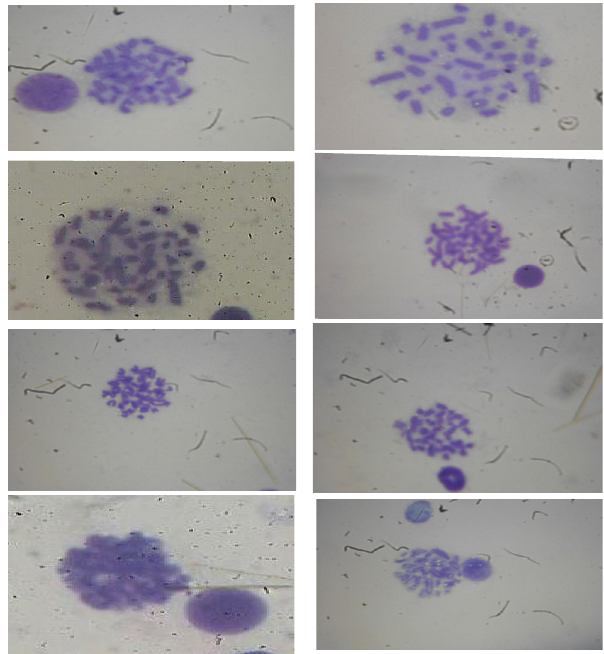
Fig. 3. Types of chromosomal aberrations in rat bone marrow cells treared with acetate lead.a: control; b: centromeric attenua- tion (Cat) and fusion (Fu); c: Fusion (Fu); d: chromasomal ring (R); e: centromeric attenuation (Cat); f: chromasomal ring (R) and fusion (F); g: deletion (D), chromasomal ring (R), gap (G); h: sticky